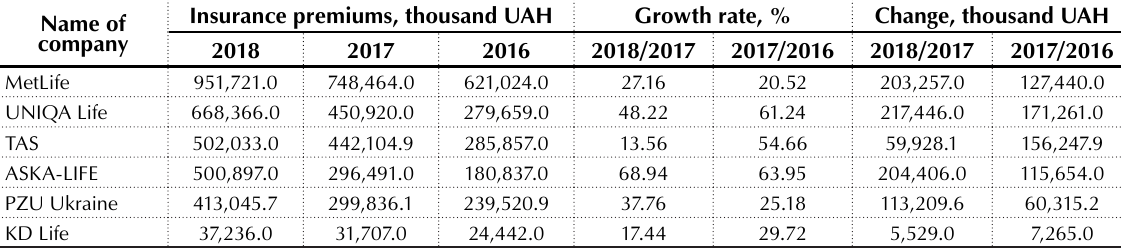
Table A3. Insurance premiums, thousand